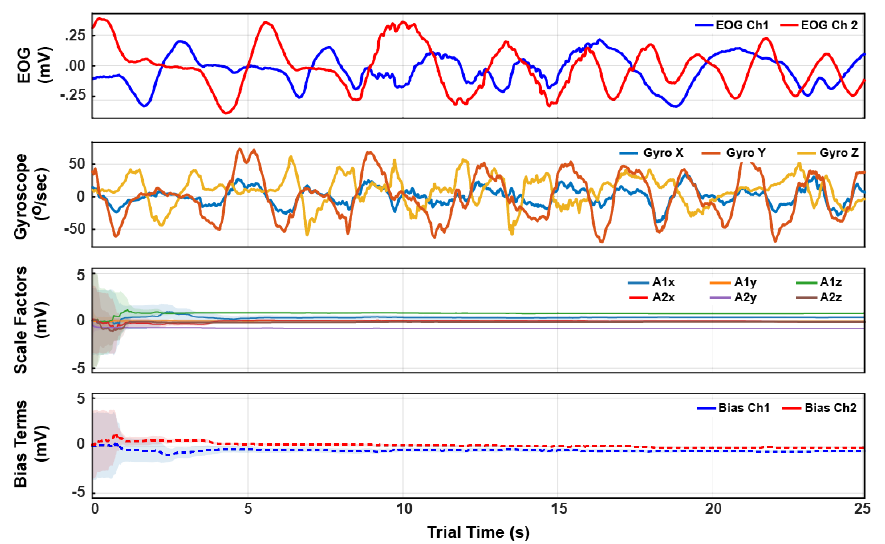
Figure 5: Example time series for a trial’s VOR-phase. The top two plots show the EOG and gyroscope data. The bottom two plots show the state estimate trajectories for the EOG calibration A and b . The shading indicates one standard-deviation of the inferred posterior. Within 5 seconds of arbitrary VOR motion, the posterior variances reach a small steady value, indicating convergence from arbitrary initial conditions to consistent state tracking